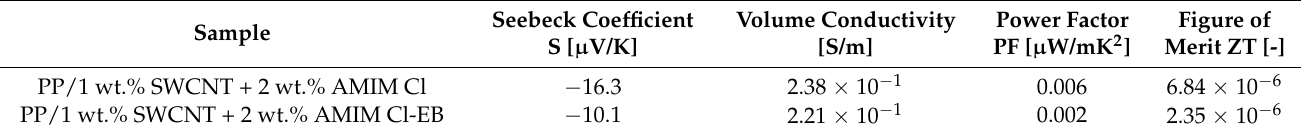
Table 7. Thermoelectric parameters at 40 ◦ C of PP/1 wt.% SWCNT composites with 2 wt.% AMIM Cl before and after electron beam irradiation (18